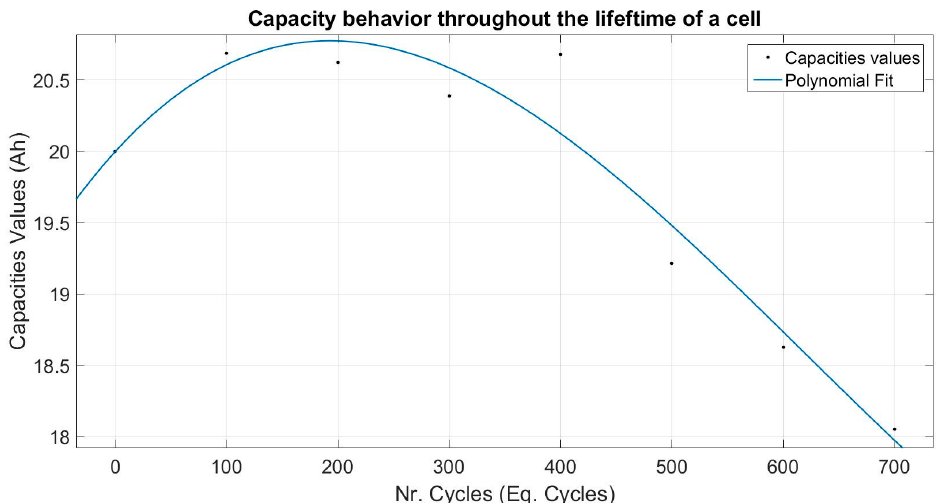
Figure 3. Capacity behavior of a lithium ion cell throughout its lifetime.